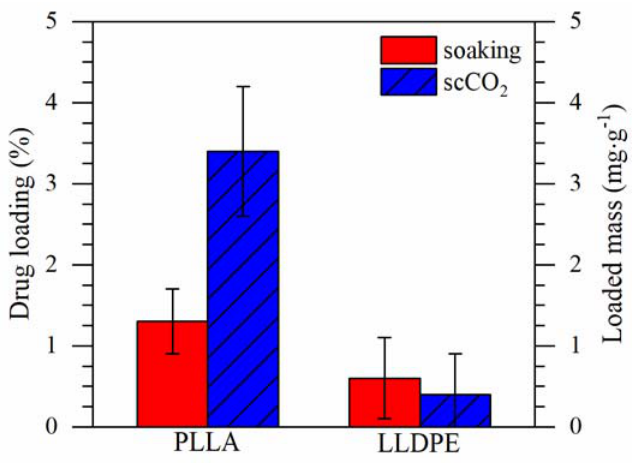
Figure 3. Drug loading (DL%) in approximately 40 mg of